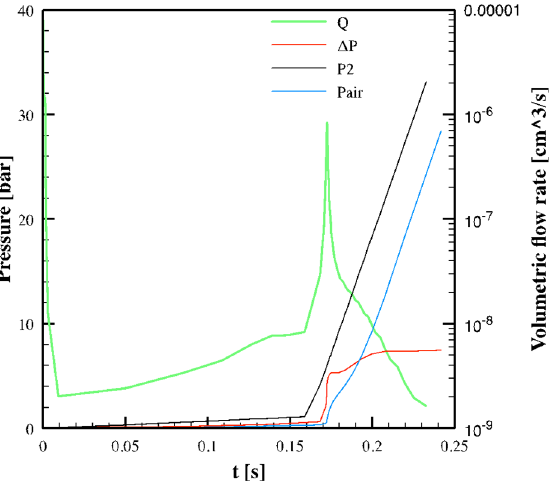
Figure 8. Evolution of pressures and volumetric flow rate in the micro-corner calculated for Passive condition. condition.